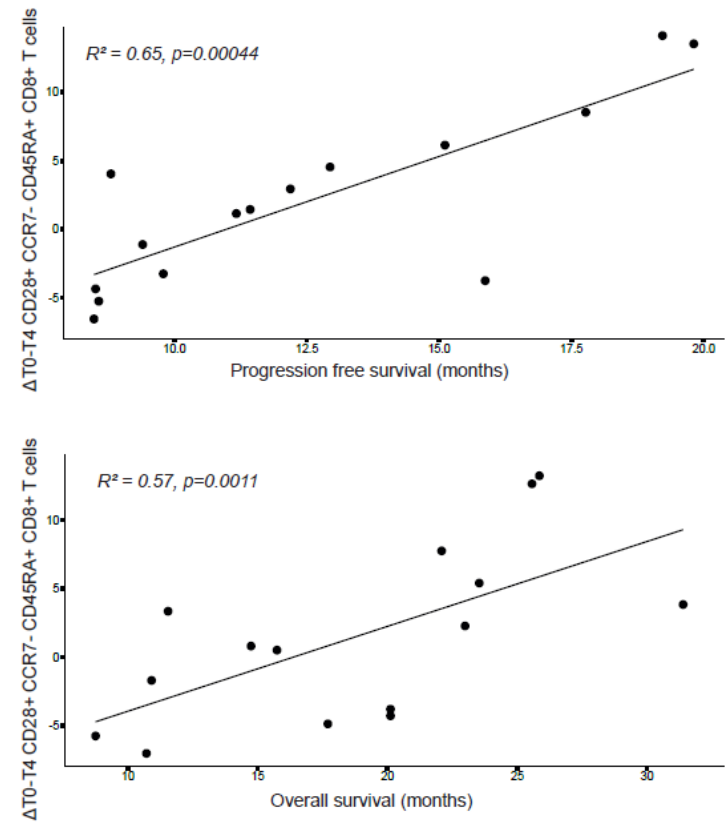
Figure 5. Treatment-induced T-cell activation correlated with improved progression-free survival. Spearman correlation plots demonstrating a positive correlation between IMM101/SBRT-induced absolute difference of CD28+ CCR7 − CD54RA+ cytotoxic T cells and progression-free survival and overall survival. N = 15.